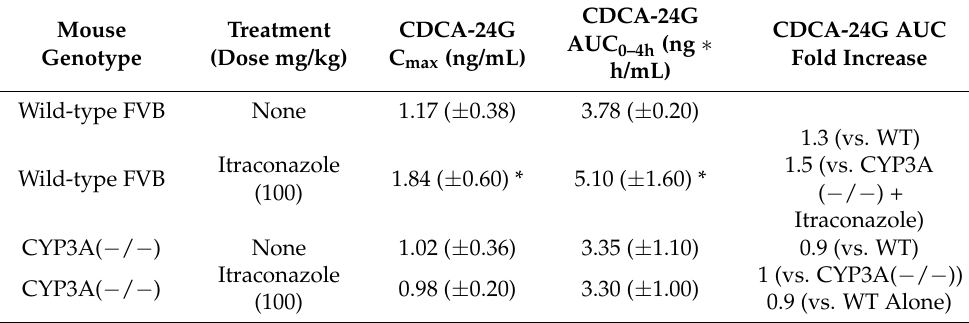
Table 2. CDCA-24G pharmacokinetic